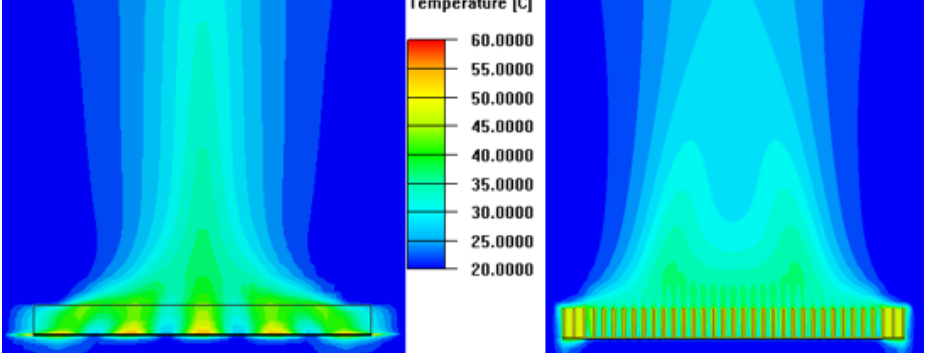
Figure 7. Temperature contours taken at the mid-plane in the longitudinal direction ( left ) and at an opening in the transverse direction ( right ) of the rectangular fins with openings at the base, illustrating vertical air flow through the openings ( L = 512 mm, W = 512 mm, H = 40 mm, and ∆ T = 40 ◦ C).